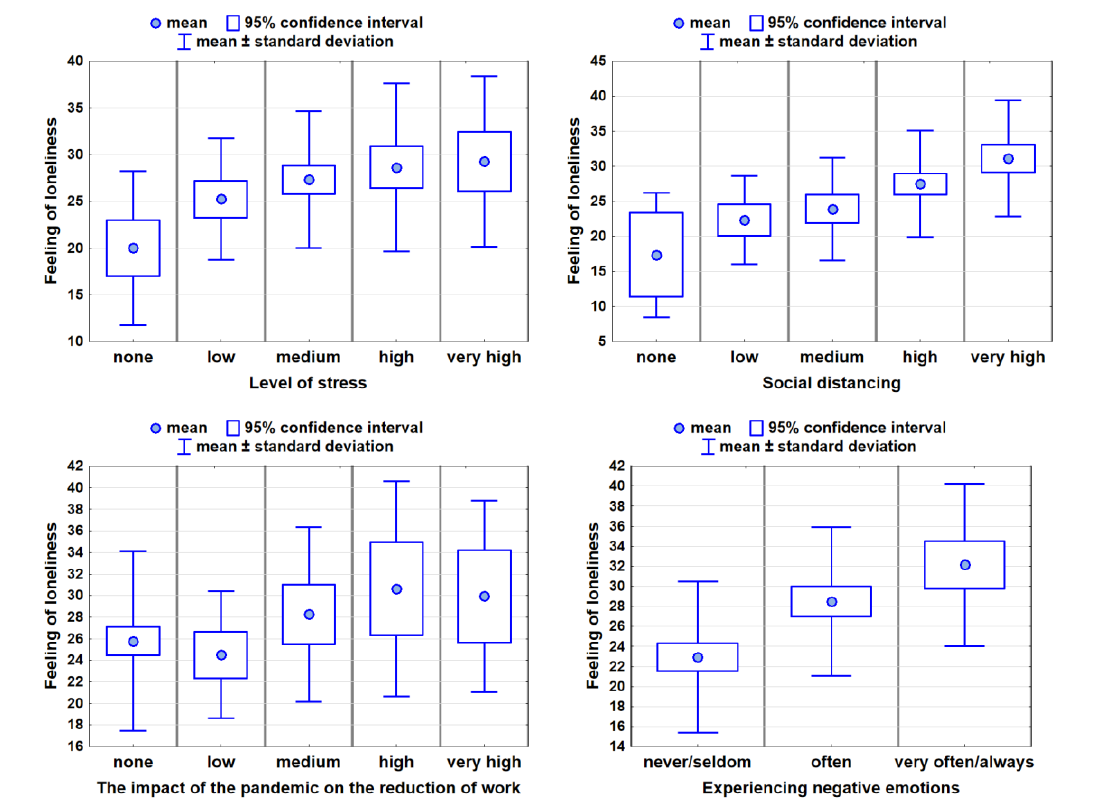
Figure 3. Feelings of loneliness in connection with psychosocial factors.